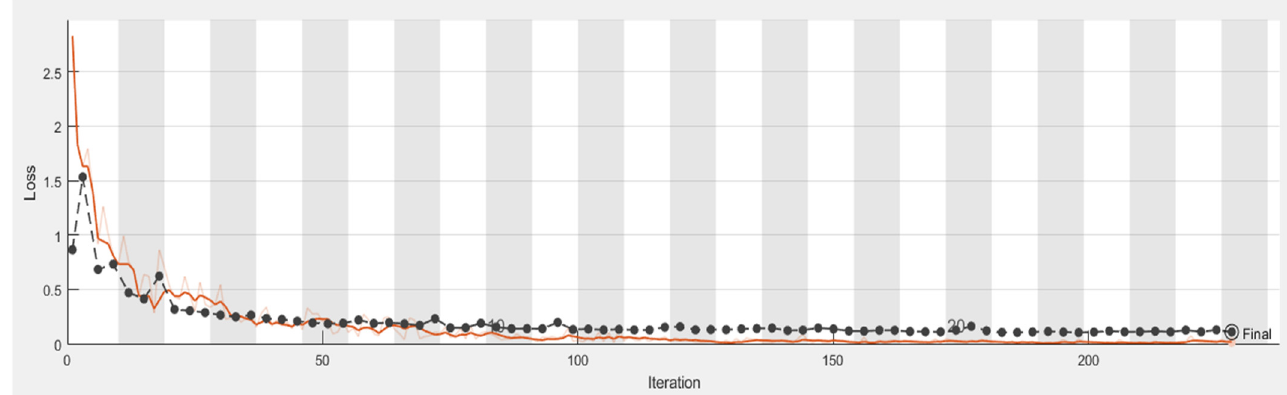
Figure 13. Training process of the model in classifying restorations, with the black and blue lines illustrating the accuracy of the test set and training set, respectively.